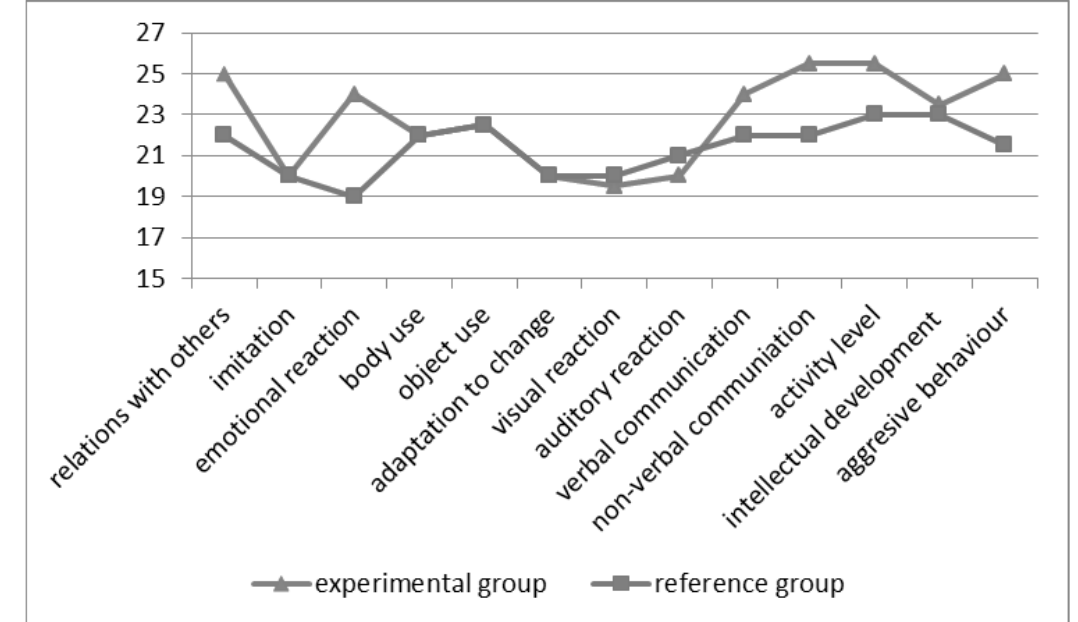
Fig. 3. Dynamics of changes in ASD children indices due to social